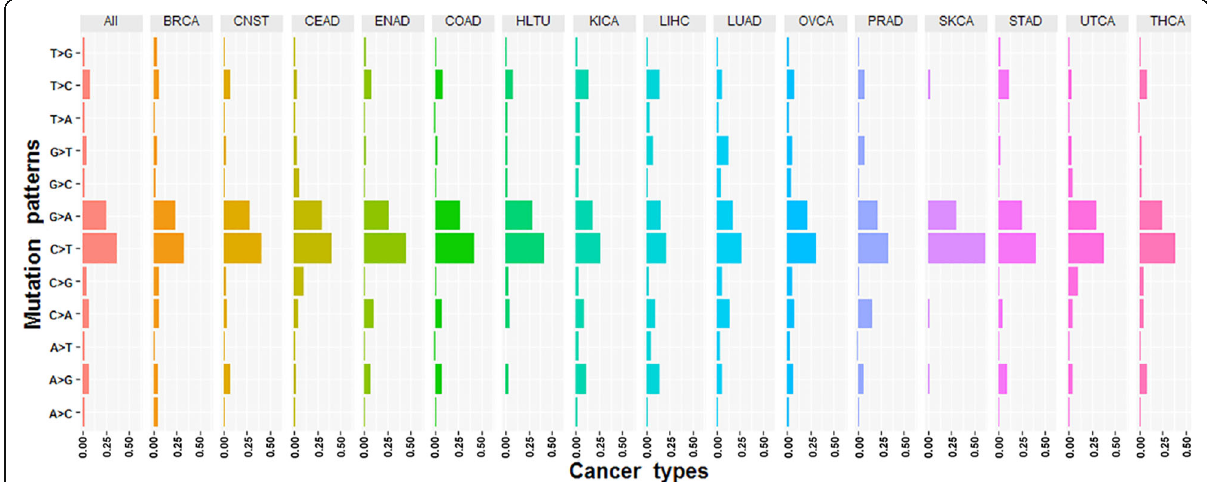
Fig. 2 Distribution of 12 possible mutation patterns of synonymous mutations in different cancer types. The x-axis represents the cancer types and the y-axis represents the 12 mutation patterns. Each bar represents the percentage of mutational types. ‘ All ’ in this figure represents the average proportions of mutational types across 15 cancer